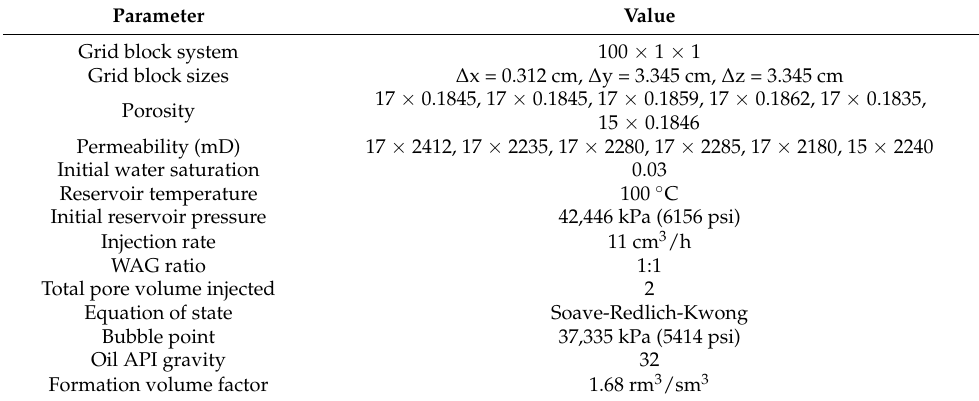
Table 10. Properties and operational parameters of the core-scale model.